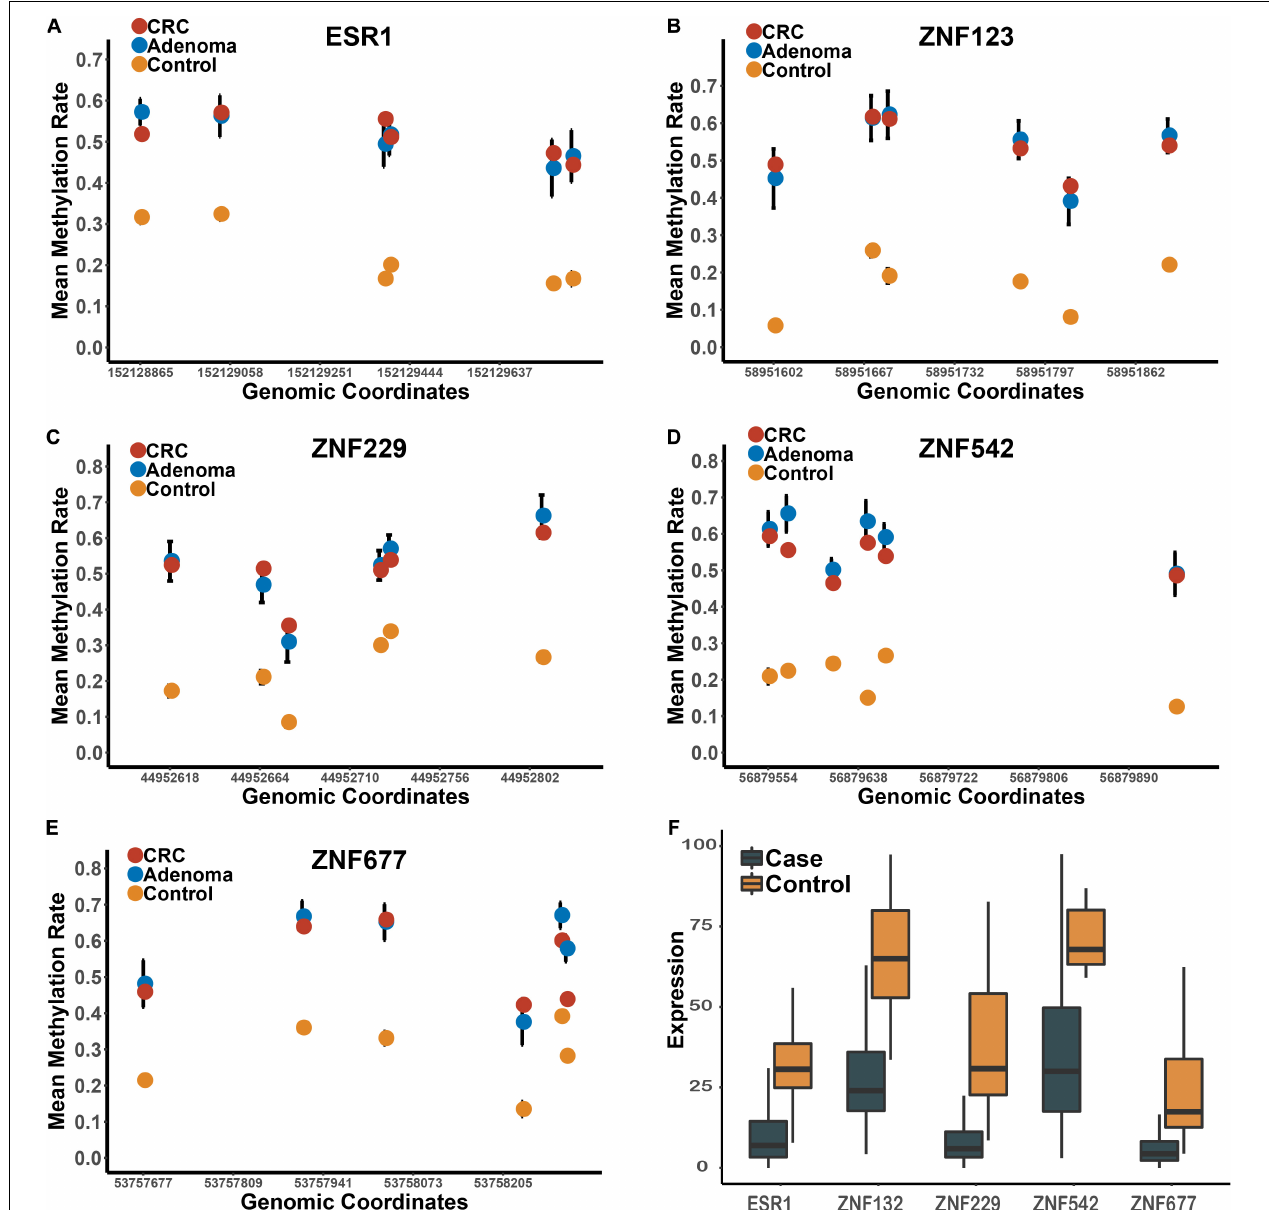
FIGURE 2 | The methylation and expression profiles of the candidate biomarkers in the discovery datasets. Panels (A–E) represents the methylation profiles of the five candidates in the tumors, adenomas and para-tumors in the integrated dataset. Panel (F) represents the expression profiles of these five candidate zinc finger genes between CRC tumor and para-tumors in